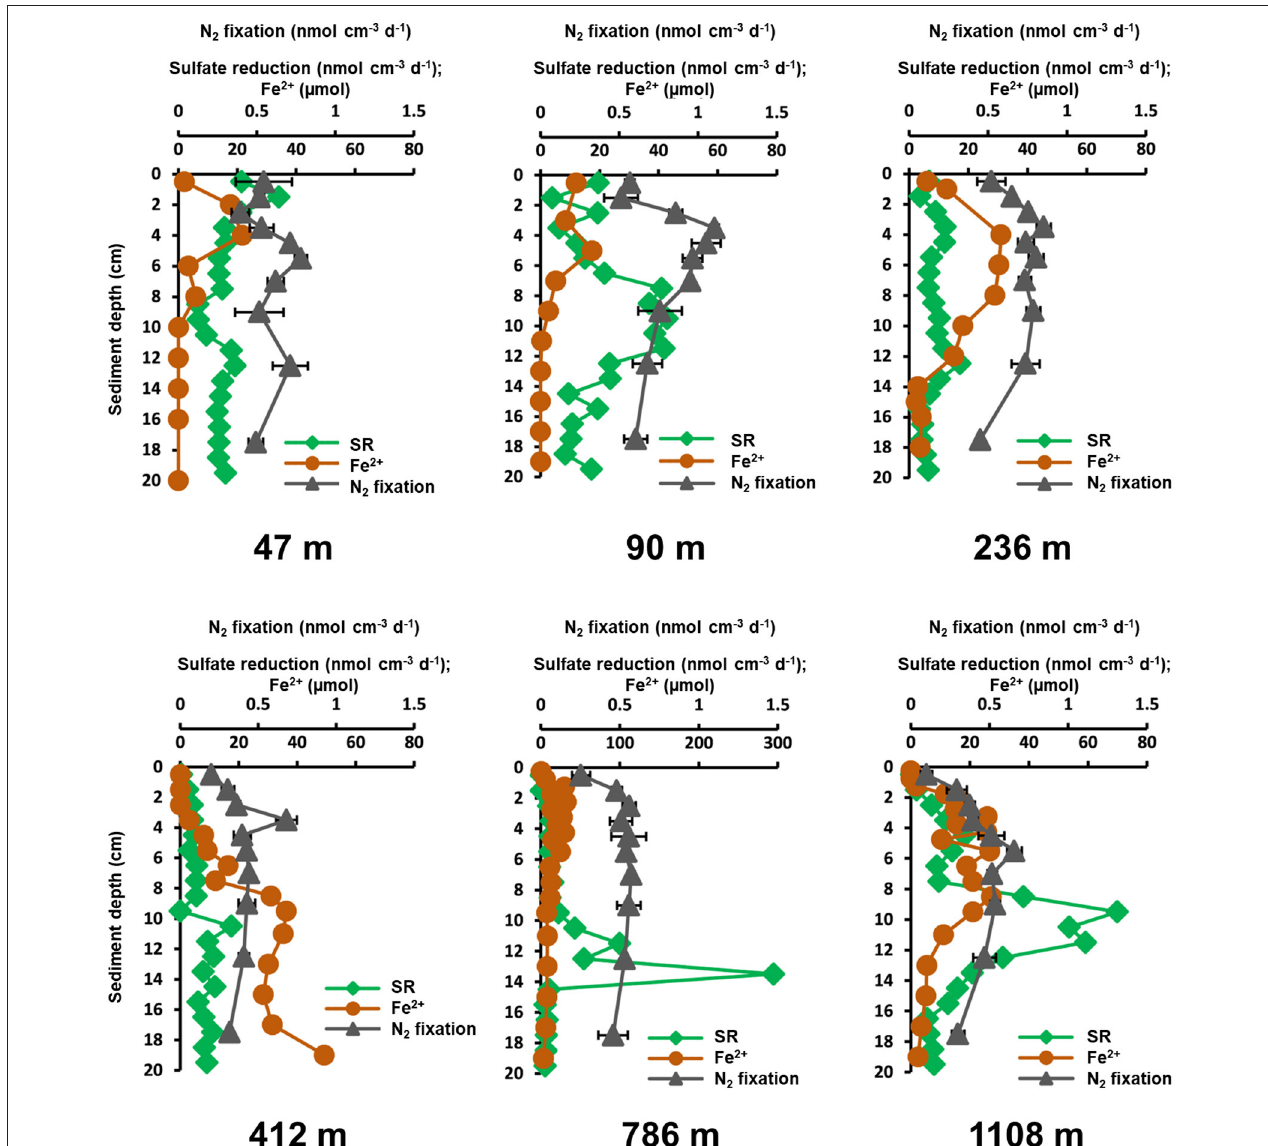
FIGURE 5 | Depth profiles of N 2 fixation (nmol N 2 cm − 3 d − 1 , gray triangles, average of three replicates plus standard deviation), sulfate reduction rates (SR, nmol SO 2